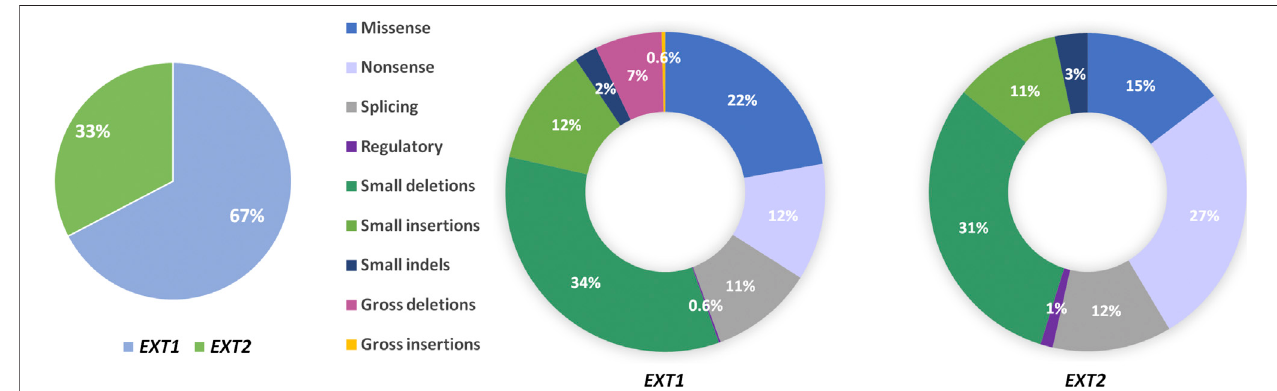
FIGURE3| Piechartsshowingthepercentageofmutationtypesfoundinthe EXT1 and EXT2 genesinpatientsaffectedwithhereditarymultipleexostoses(HMEs). Data were obtained from Human Gene Mutation Database (HGMD v.2021.1; accessed on 25 th of May).